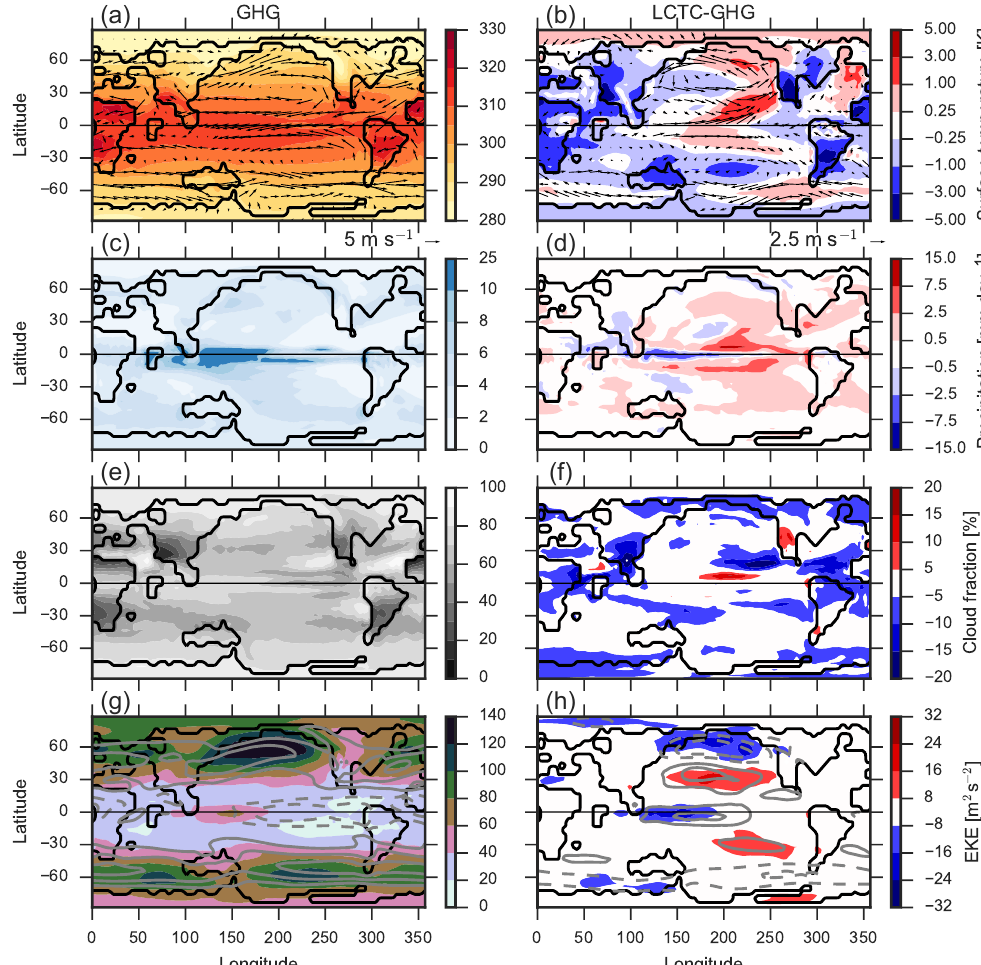
Figure 2. Annual-mean climatology in the GHG run (left column) and its change in the LCTC case (right column) of (a, b) surface temperature (shading) and 900hPa wind (arrows), (c, d) precipitation, (e, f) cloud fraction, and (g, h) eddy kinetic energy (shading) and zonal wind at 700hPa (contours; contour intervals 4ms − 1 in g and 2ms − 1 in h